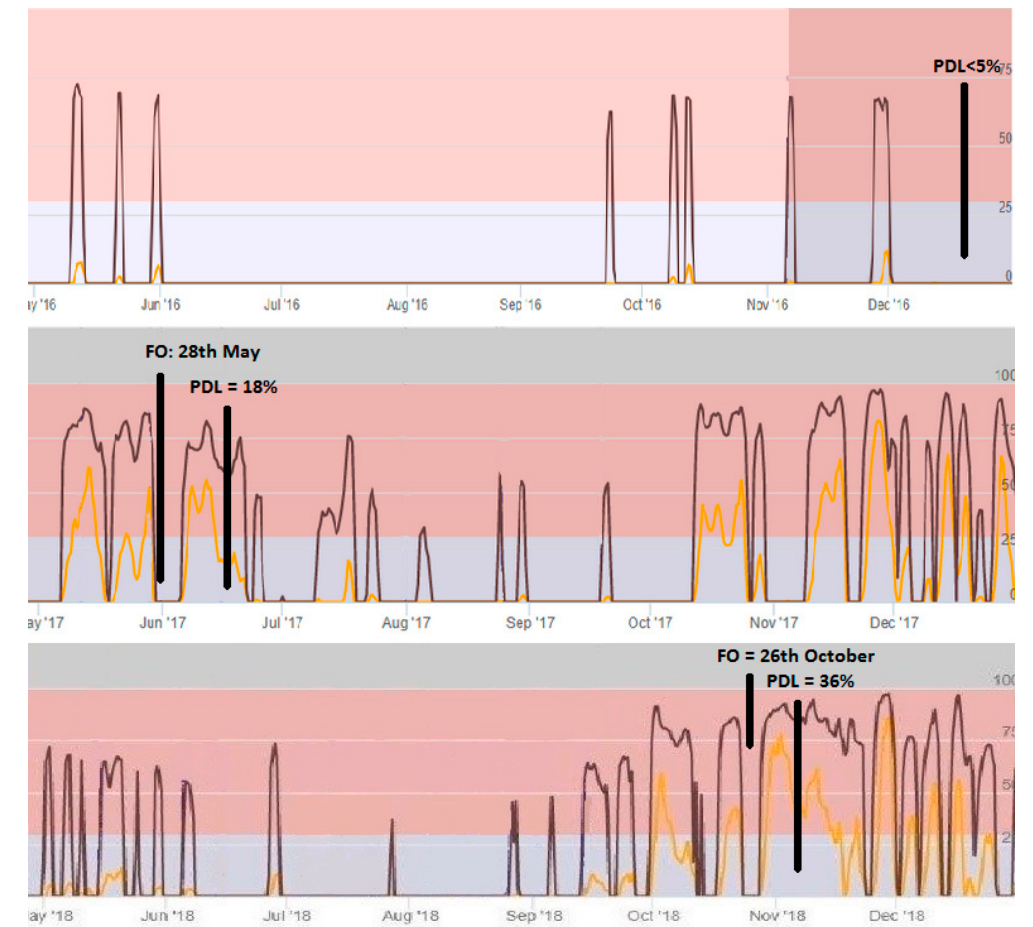
Figure 4. Predictions (as presented on the screen of the computer) of the generic model (orange line) and polynomial models (black line) to forecast infections from the fungus Venturia oleaginea on olive trees for the period May to December of three consecutive years (2016, 2017, 2018) (FO = First Observation; PDL = Percentage of the Diseased Leaves).